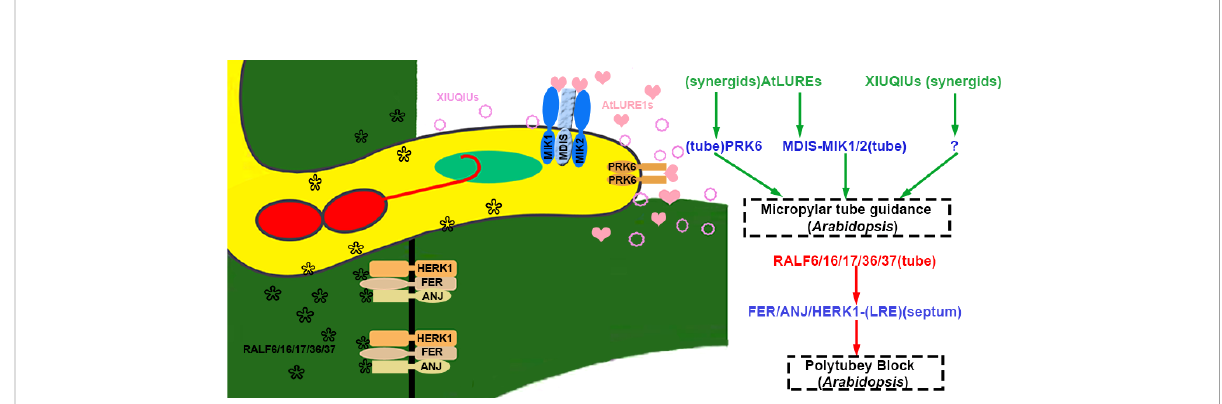
FIGURE 4 The micropyle guidance and polytubey block of pollen tubes. In Arabidopsis thaliana , pollen tubes penetrate the septum, and the RALF6/16/17/ 36/37 secreted by the pollen tube interacts with the septum-speci fi c FER/ANJ/HERK1 to initiate the polytubey block. XIUQIUs and AtLURE1s secreted by synergid cells diffuse along the funiculus. AtLURE1s interact with PRK6 and/or MIK1/2-MDIS of the pollen tube to guide the pollen tube to grow towards the micropyle. The peptides are highlighted in green and red to represent activation or suppression, respectively. The blue represents receptor complexes and the co-receptors are shown in parentheses. Question marks indicate unidenti fi ed signal components. The source of peptides and receptors is shown in parentheses. Abbreviations for all small peptides and receptors are elucidated in the